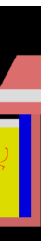
Figure 4. Schematic diagram of the high-energy particle probe structure.